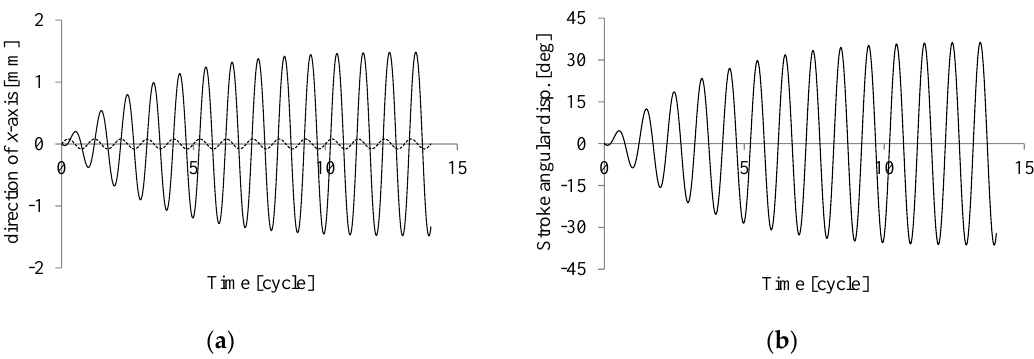
Figure 14. Time histories of ( a ) the tip displacement (solid line) and the base displacement (dotted line) in the x -direction and ( b ) the flapping angular displacement.